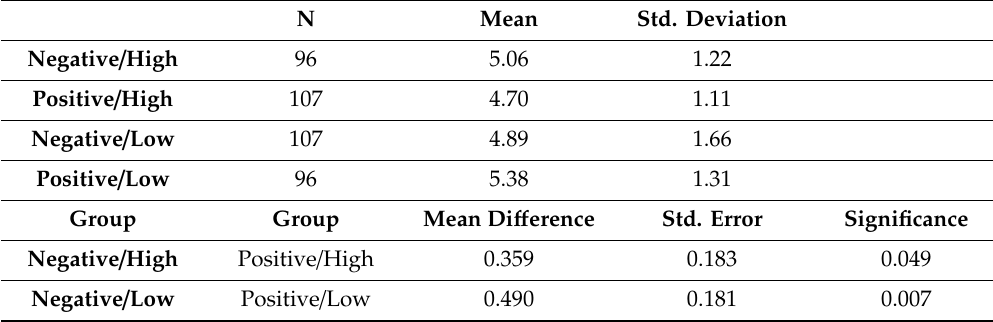
Table 6. Follow-up contrast analysis (frame and issue